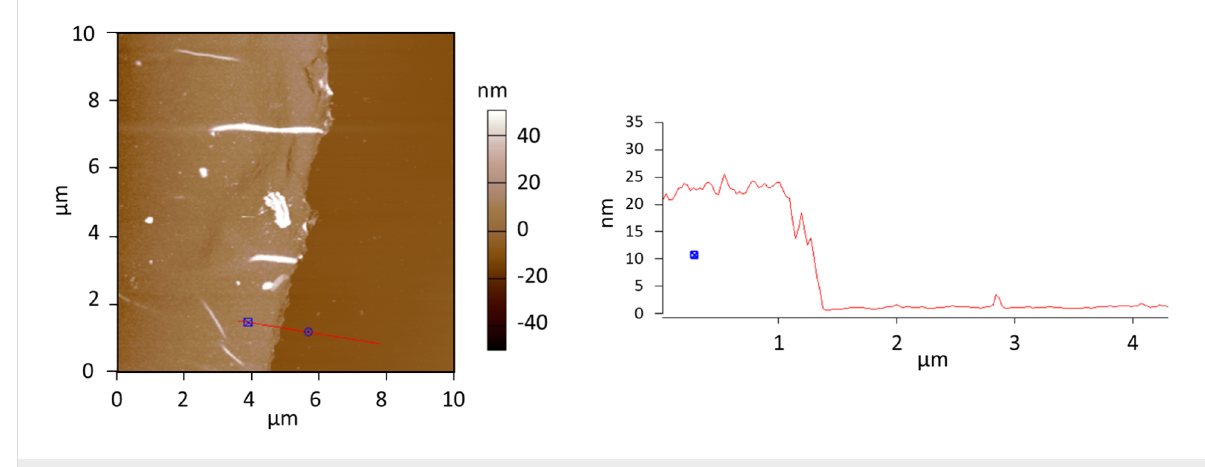
Figure 3: AFM image and line-scan across the edge of the CMP thin film.